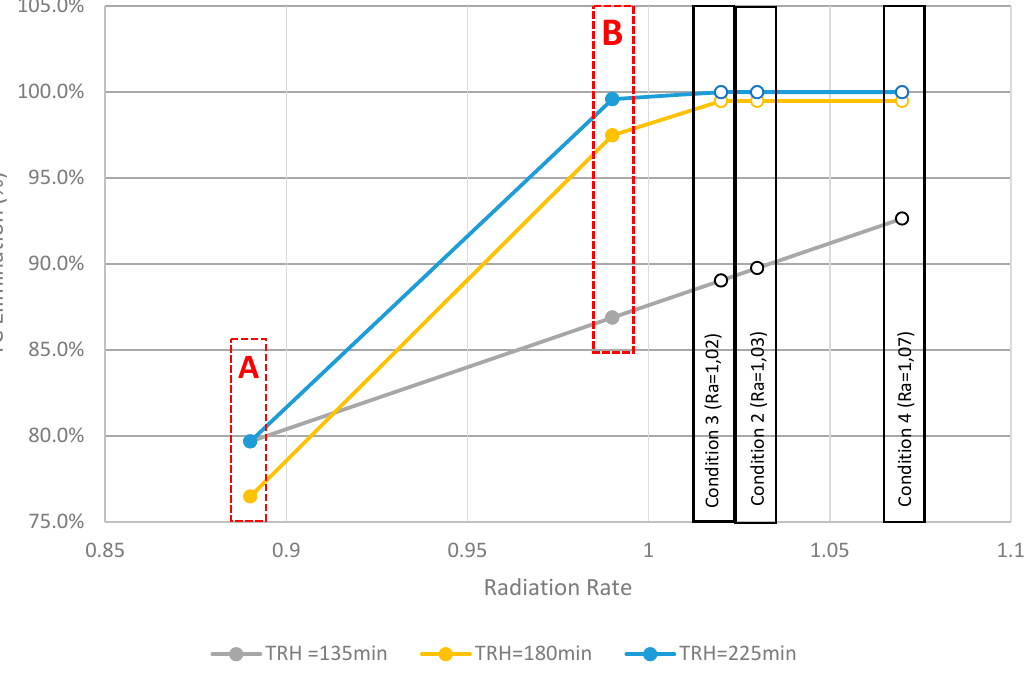
Figure 9. Theoretical relationship between the radiation ratio and the total removal of coliforms.